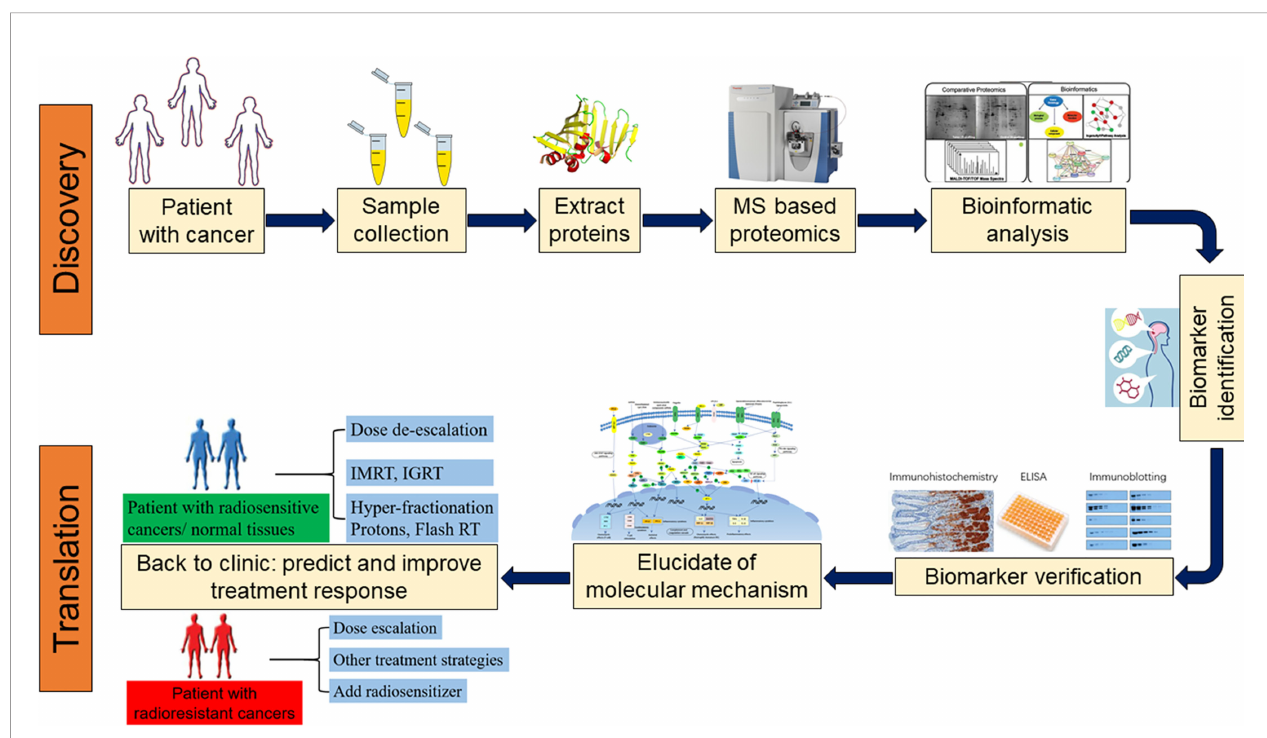
FIGURE 1 | Proteomics approaches for the discovery, validation, and clinical application of biomarkers. (MS, mass spectrometer; IGRT, Image-guided radiation therapy; IMRT, Intensity-modulated radiation